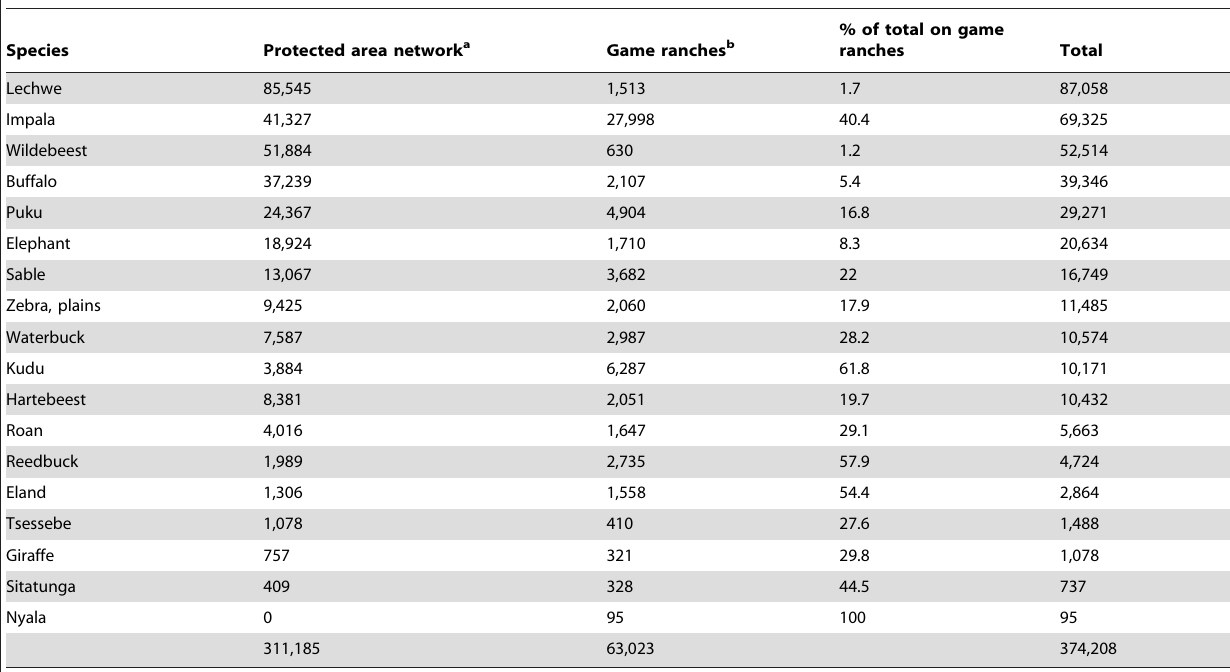
Table 4. Estimated wildlife populations in national parks (data available for 61,462 km 2 of the , 64,000 km 2 ), game management areas (GMAs, data available for 159,654 km 2 of the , 166,000 km 2 ) (together ‘protected area network’) and game ranches (5,829 km 2 ) in Zambia (excluding species of bushbuck size and smaller, and hippopotamuses for which count data were not available).